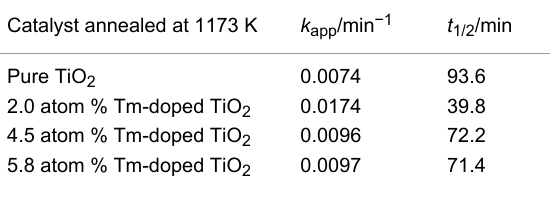
Table 3: Values for k app and t 1/2 obtained for the photocatalytic activity tests performed. Catalyst annealed at 1173